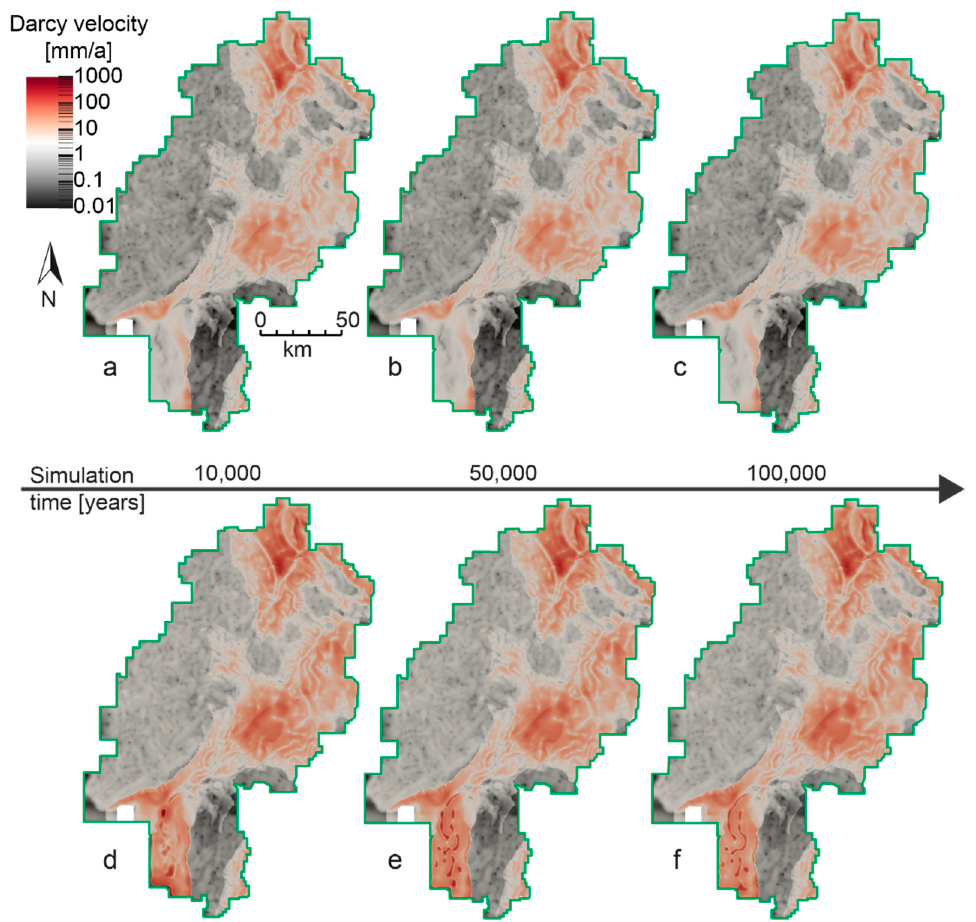
Figure 9. Maps of Darcy velocities in mm per year at 1 km depth. ( a – c ) results of coupled thermo-hydraulic simulations with constant viscosity and density after (a) 10,000, (b) 50,000 and (c) 100,000 years. ( d – f ) results of coupled thermo-hydraulic simulations with temperature and pressure dependent varying viscosity and density after (d) 10,000, (e) 50,000 and (f) 100,000 years.